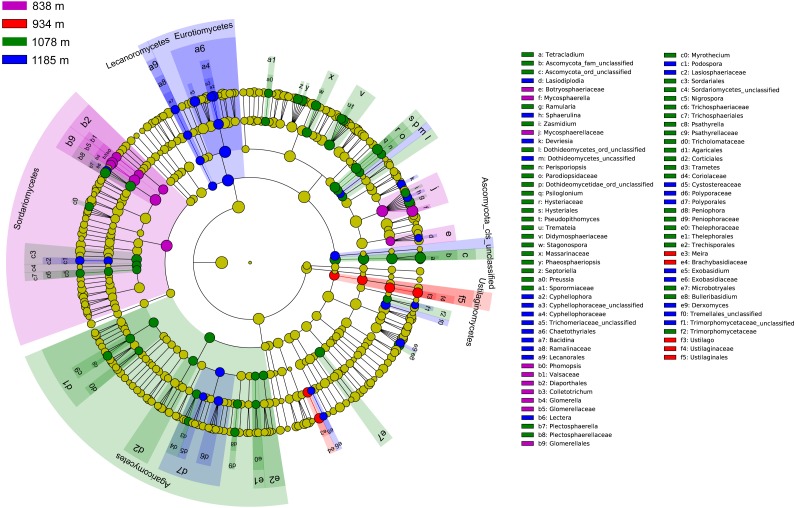
Cladogram showing significant discriminative taxa of the phyllosphere fungi associated with Mussaenda shikokiana along the elevation gradient.The filled circles from inside to out indicate the taxonomic levels with phylum, class, order, family and genus. Circles or nodes shown in color corresponding to that of different elevation sites represented a significantly more abundant group.